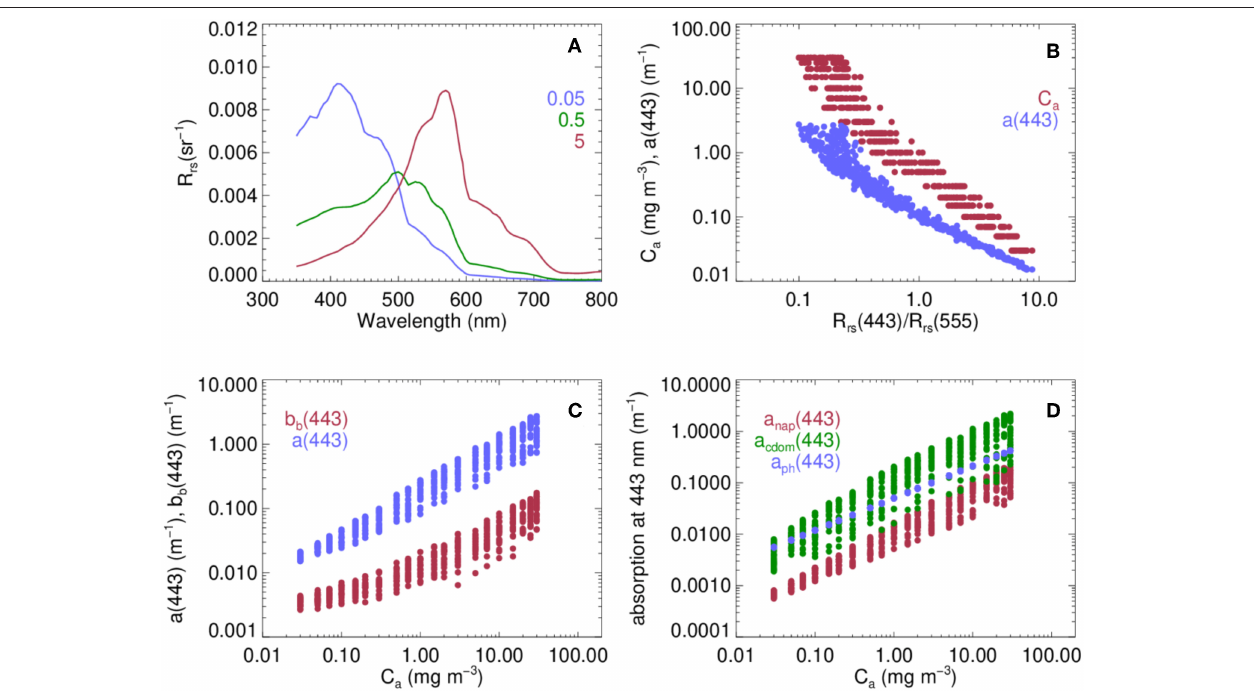
FIGURE 1 | Characteristics of the simulated AOP-IOP dataset: Three example R rs ( λ ) spectra selected from the synthesized AOP-IOP dataset for C a of 0.05, 0.5, and 5mg m − 3 (A) ; C a and a (443) as a function of the ratio of R rs (443): R rs (555) (B) ; b bp (443) and a (443) as a function of C a (C) ; and, a nap (443), a cdom (443), and a ph (443) as a function of C a (D)